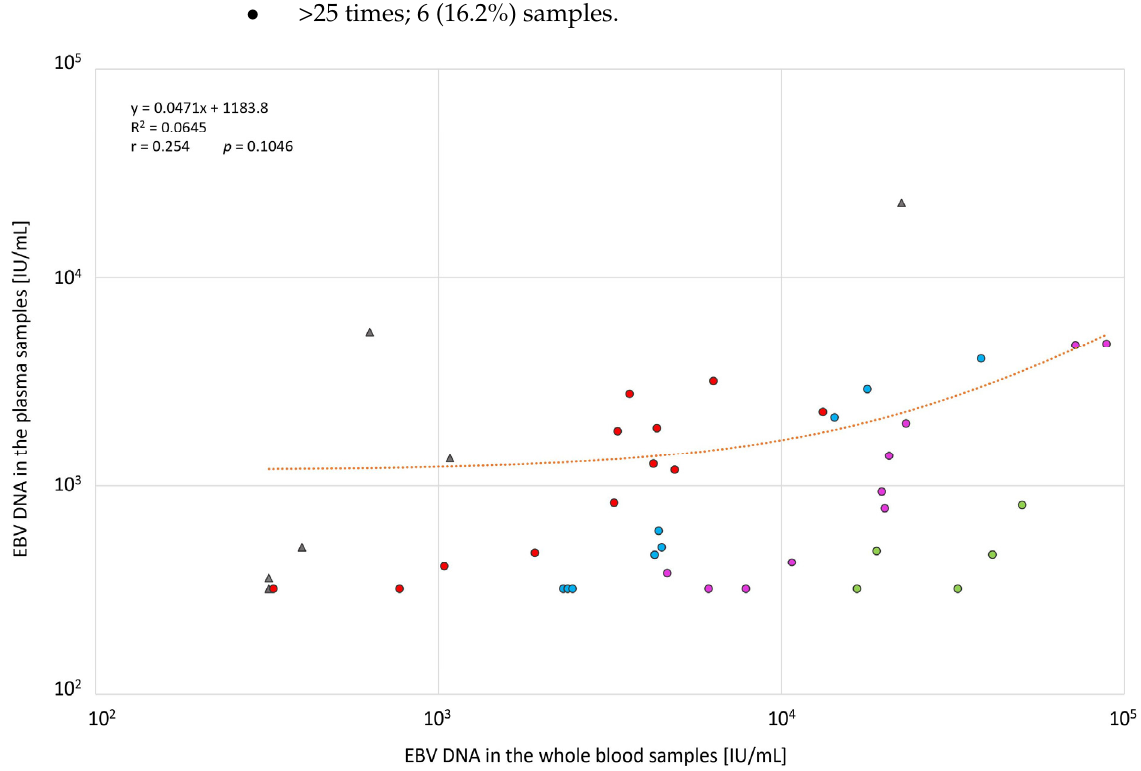
Figure 1. EBV DNAemia (IU/mL) distribution in the whole-blood ( n = 42) versus the corresponding plasma samples ( n = 42). The chart does not include the outlier (x = 5,500,000; y = 33,250). Samples representing higher EBV DNAemia values compared to the corresponding plasma samples are marked with red (up to 5 times higher), blue (6–10 times higher), pink (11–25 times higher), and green (>25 times higher) dots. Samples with higher plasma EBV DNAemia values or equal values are marked with gray triangles. The orange line represents the regression curve. p , probability value; r, Pearson’s correlation coefficient; R 2 , coefficient of determination. Table 3. The list of EBV DNA levels (IU/mL) for the samples with higher plasma ( n = 5) DNAemia when compared to the whole-blood counterparts ( n = 5).